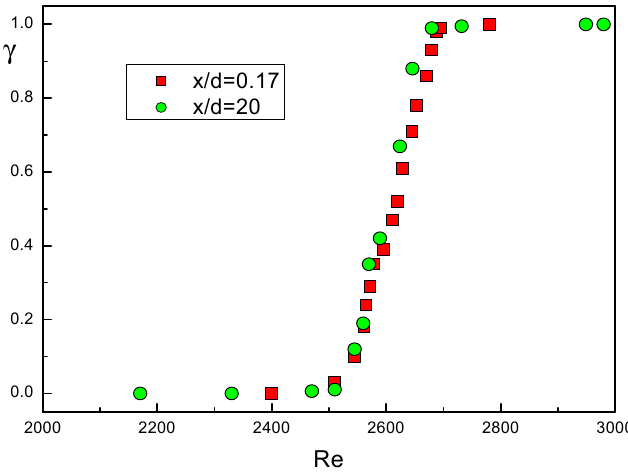
Figure 4. Intermittency factor in the air flow.